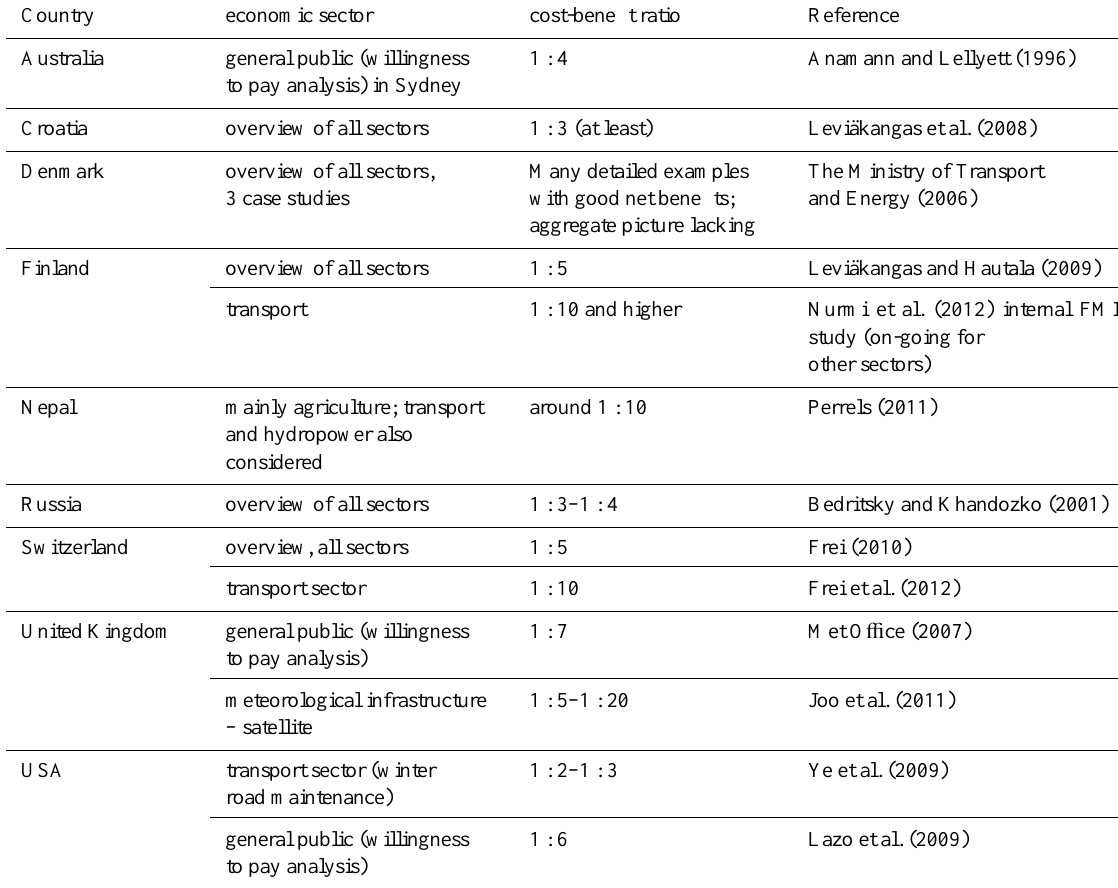
Table 1. Overview of published cost-benefit analysis within di ff erent weather services, based on avoided costs unless otherwise